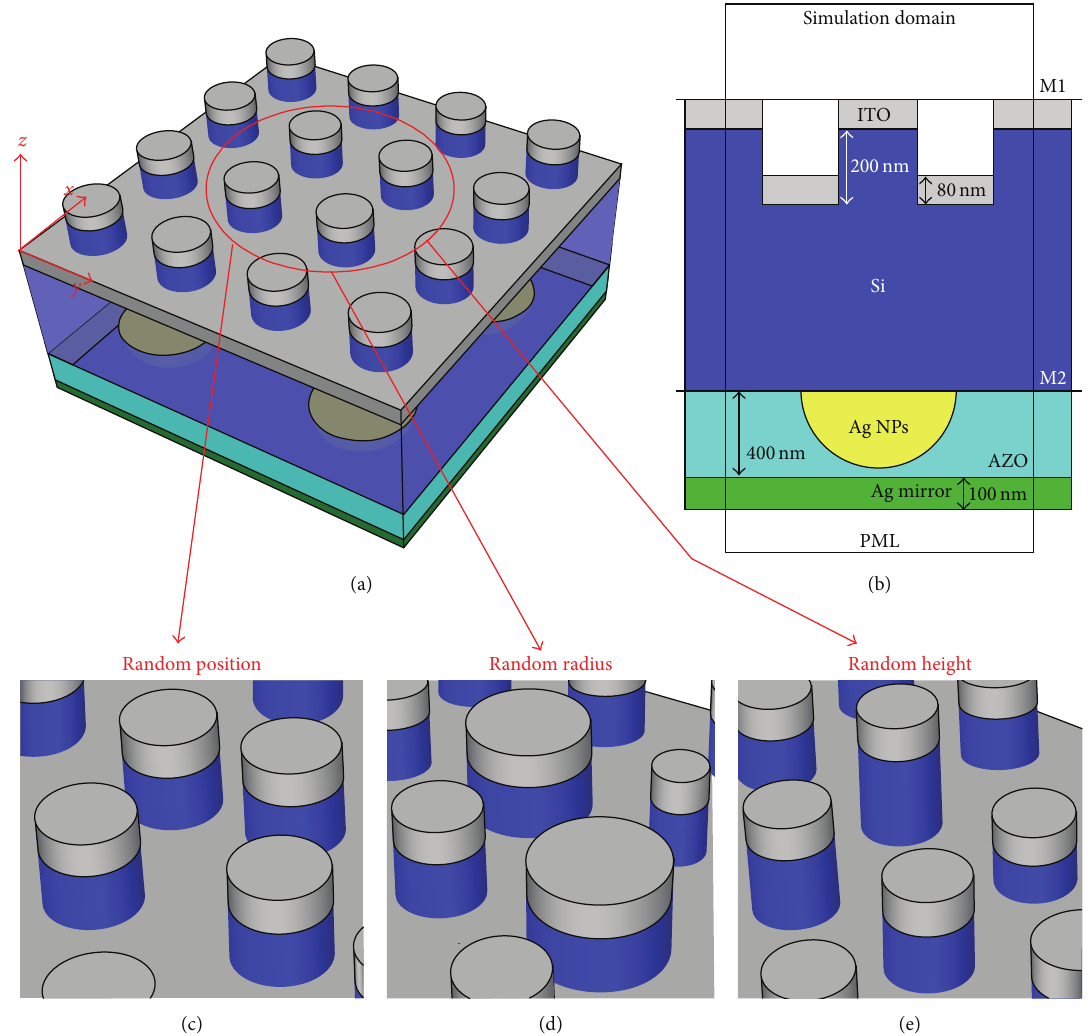
Figure 1: The solar cell with hybrid light trapping structure (a) and the solar cells with random grating pillar position (PRSC) (b), with random grating pillar radius (RRSC) (c), and with random grating pillar height (HRSC) (d) used in the